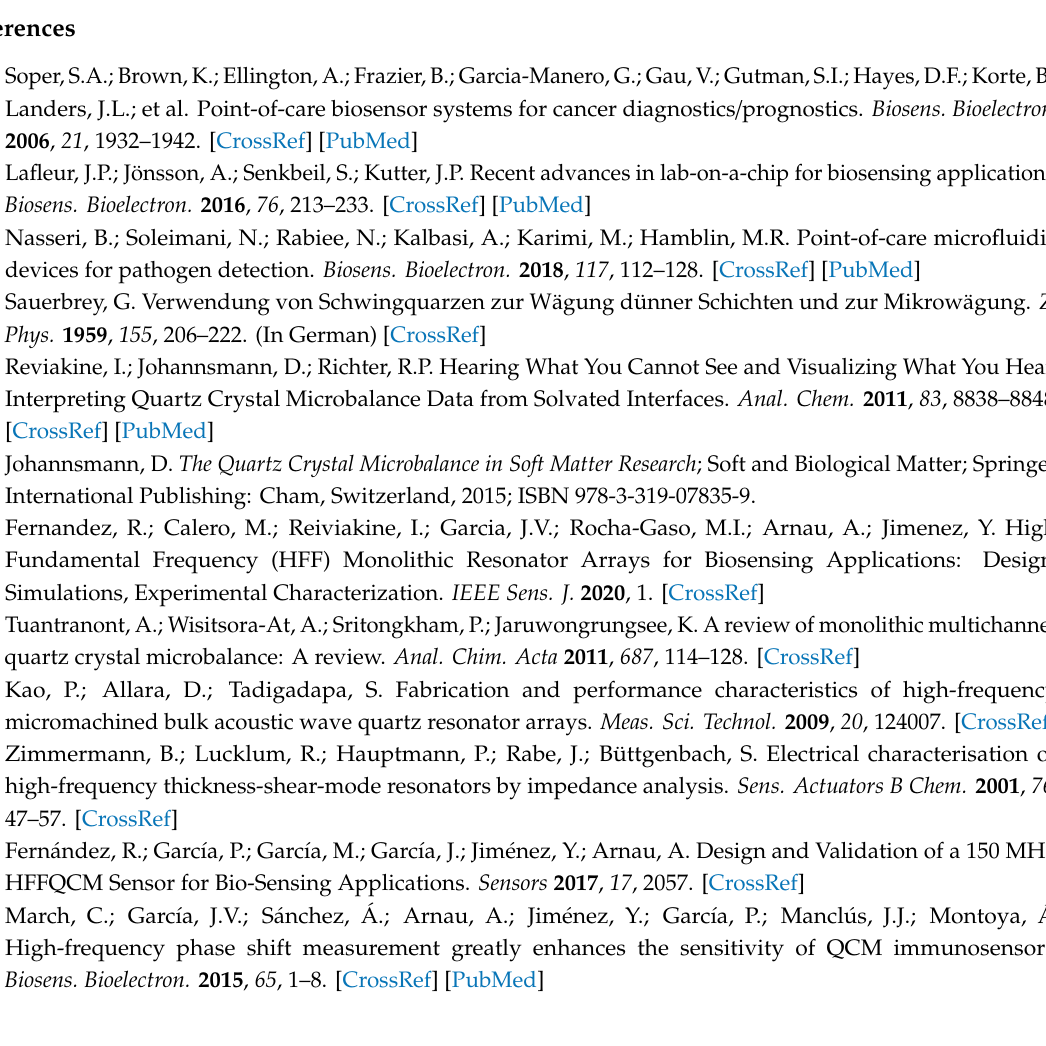
the Monolithic 150 MHz HFF QCMD sensor array. Quantification of adsorbed protein masses with the array and the individual sensors. Literature values for the dimensions and adsorbed layer masses for BSA, bBSA, and Nav. Peclet numbers and depletion thickness layer calculation. Figure S1. Monolithic 150 MHz HFF-QCMD sensor arrays. Numbers indicate the i-th element of the array, where i = r +4(c − 1) with r = 1–4 and c = 1–6 row and column indexes, respectively. Table S1. Quantification of adsorbed protein masses. Table S2. Literature values for the dimensions and adsorbed layer masses for BSA, bBSA, and Nav. Table S3. Pe H calculated for different flow rates and biomolecules. Table S4. 〖 Pe 〗 _S calculated for different gasket deformation.